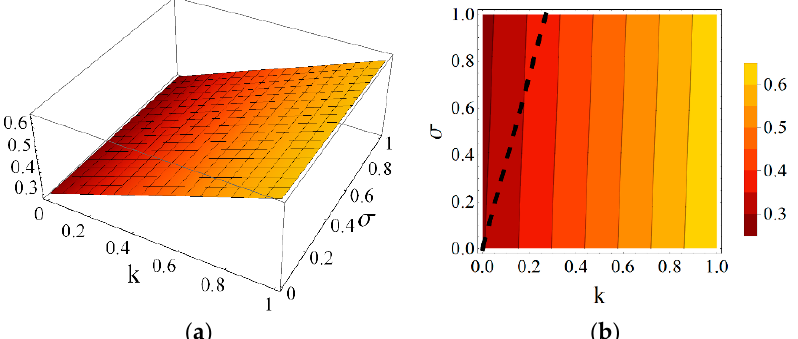
Figure 7. Shear modulus G 1 (divided by the factor EA / a 2 ) with the limiting condition G 1 > 0: ( a ) 3D plot; and ( b ) contour plot.